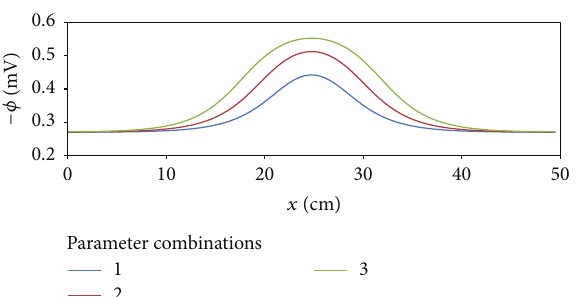
Figure 4: Electrical potential profiles on concrete surface for different corrosion sizes.